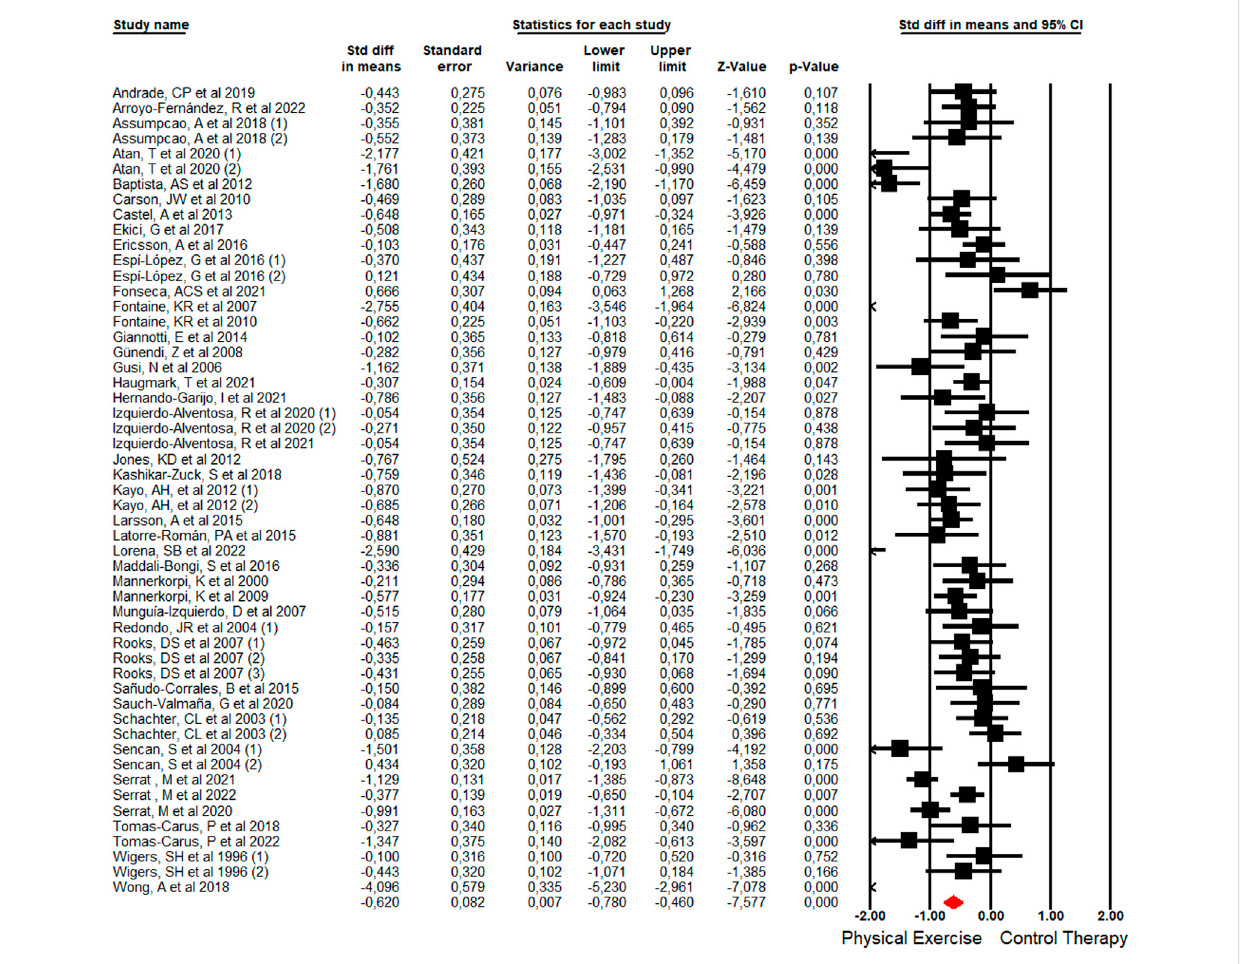
a medium-sized effect indicating the superiority of PEBT for improving the physical dimension of QoL compared to other (Table 2; Figure 4A). Speci fi cally, data from 23 studies with 27 independent comparisons indicated that PEBT led to a 9.7- point increase in scores on the physical component of the SF-36 when assessed immediately after therapy (95% CI 6.44 – 13.52; p < 0.001). No risk of publication bias (Egger p = 0.48) was found (Supplementary Figure S3), and the level of heterogeneity was very low (I 2 = 8.7%; Q = 22.4 (df = 26); p = 0.66). Sensitivity analysis only showed 10.7% of variation from the original pooled effect. Subgroup analysis based on the speci fi c mode of PEBT used revealed a medium-sized effect of circuit-based exercises (SMD = 0.5; 95% CI 0.32 – 0.69; p < 0.001) but no effect of exercise movement techniques (SMD = 0.59; 95% CI − 0.11 – 1.28; p = 0.096) (Supplementary Table S2). Subgroup analysis based on follow-up time revealed that PEBT did not have a signi fi cant effect on physical QoL at 24 weeks (SMD = 0.21; 95% CI − 0.16 – 0.58; p = .26) or 48 weeks (SMD 0.07; 95% CI − 0.25 – 0.39; p = .67) (Supplementary Table S2).